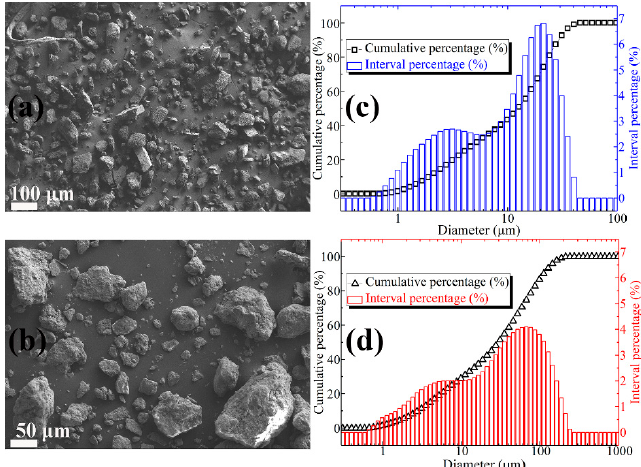
Figure 1. ( a ) SEM image of MgO particles; ( b ) SEM image of FD particles; ( c ) particle size distribution of MgO powder; ( d ) particle size distribution of FD